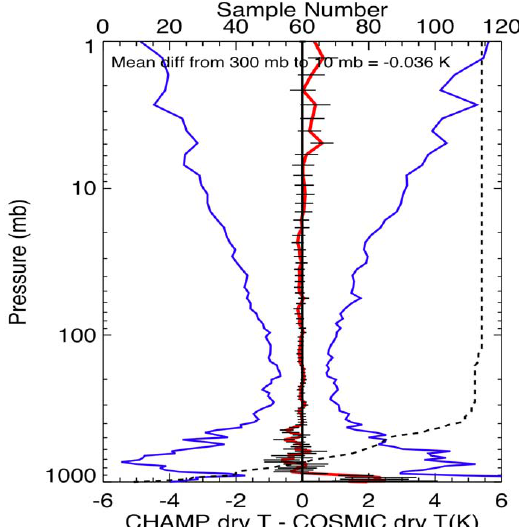
Fig. 31. Comparison of nearby (within 60min and 50km) CHAMP (launched in 2001) and COSMIC (launched in 2006) dry tempera- ture soundings showing that the retrieved soundings from the two different missions are comparable. The red line is the mean dif- ference. The blue lines are the standard deviations, and the dashed black line is the number of pairs of data at each level. The mean bias is less than 0.05K (Ho et al.,